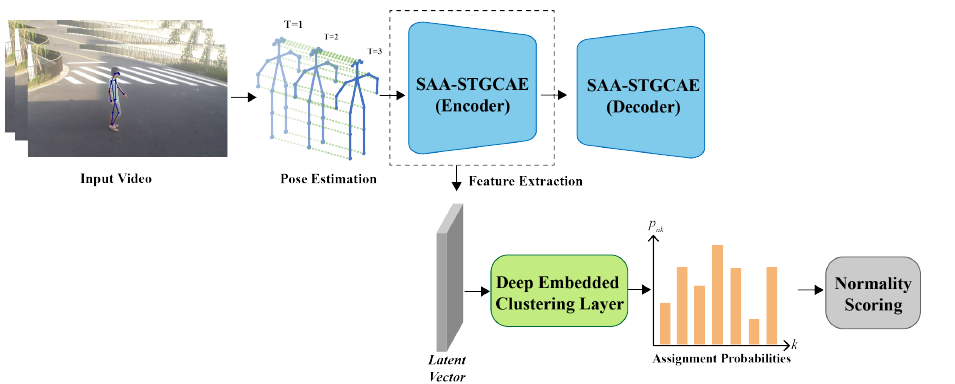
Figure 1. Framework Diagram: First, we perform pose estimation algorithm to extract skeletons for each frame in each video. The extracted pose of skeleton is encoded to generate a latent vector using the encoder part of a spatial temporal self-attention augmented graph convolutional autoencoder. The deep embedded clustering layer is used to softly assign the latent vector to the clusters, and P nk represents the probability of the sample being assigned to the cluster k